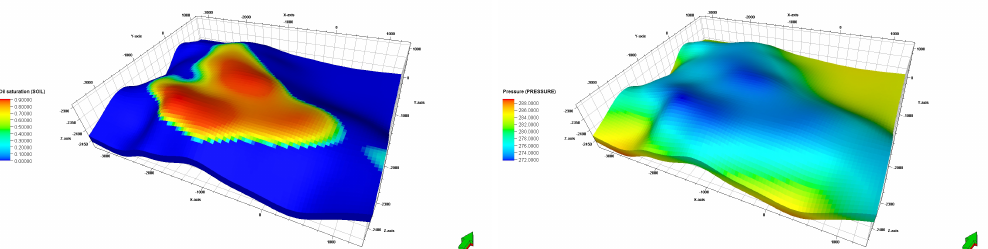
Figure 14. Distributions of oil saturation ( left ) and initial pressure ( right ) in the reservoir model. Source: AGH UST Drilling Oil and Gas Faculty synthetic benchmark